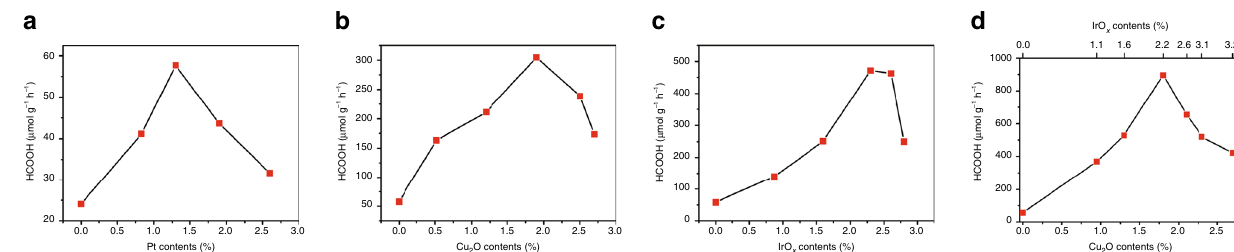
Fig. 5 The optimal contents of cocatalysts for CO 2 reduction. Change in HCOOH evolution rate a on Pt/SiC with increasing Pt content, b on Cu 2 O – Pt (1.3 wt%)/SiC with increasing Cu 2 O, c on Pt (1.3 wt%)/SiC/IrO x with increasing IrO x , and d on Cu 2 O – Pt/SiC/IrO x with increasing Cu 2 O and IrO x , in spatially separated reactor under visible light irradiation. Reaction conditions: 50 mg SiC-based photocatalyst and 300 mL of 2 mM FeCl 2 aqueous solution were placed in the CO 2 -reduction chamber, 100 mg Pt/WO 3 and 300 mL of 2 mM FeCl 3 aqueous solution in the H 2 O oxidation chamber, the pH of solution was adjusted to 2.3 by adding hydrochloric acid to prevent precipitation of the iron ions aqueous solution.